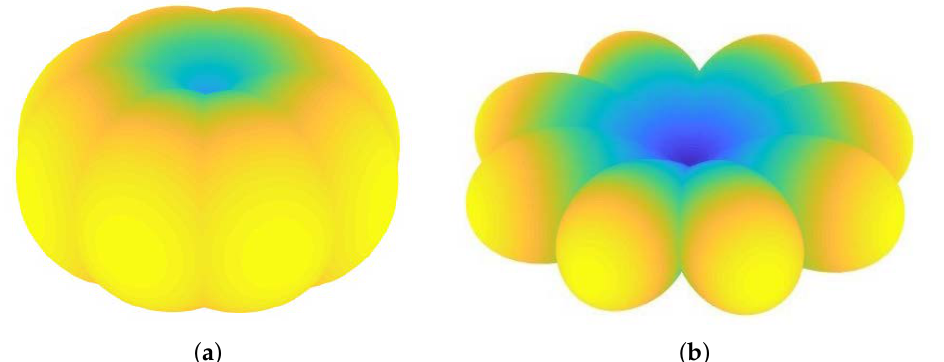
Figure 2. 3D SBA composite radiation patterns of the Energy Supplier node at 2.45 GHz ( a ) and 5.2 GHz ( b ).